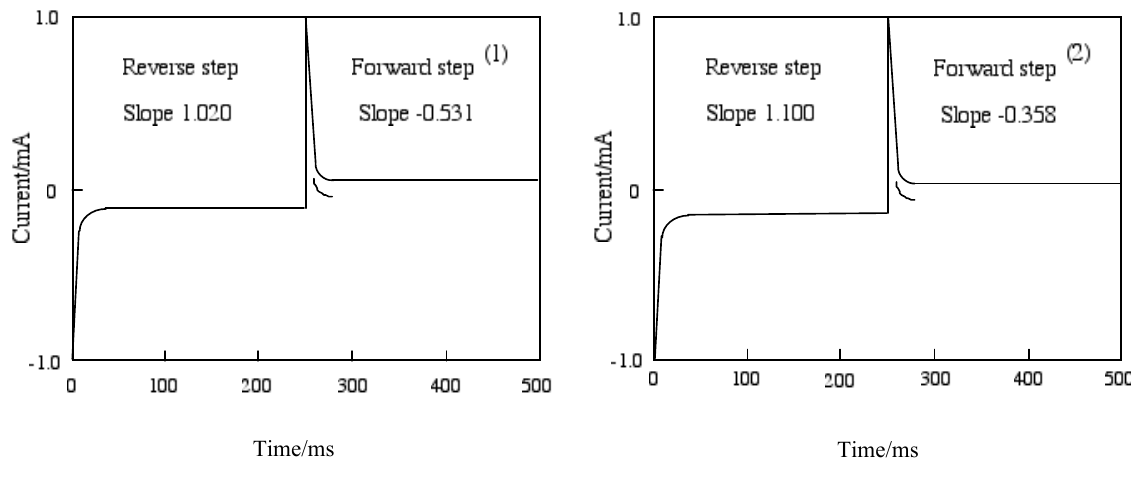
Figure 7. Chronoamperometry and the slope calculated from Cottrell plot of cobalt phthalocyanine tetrasulfonic acid. Potential step; -1.2–1.6 V vs. Ag/AgCl, time